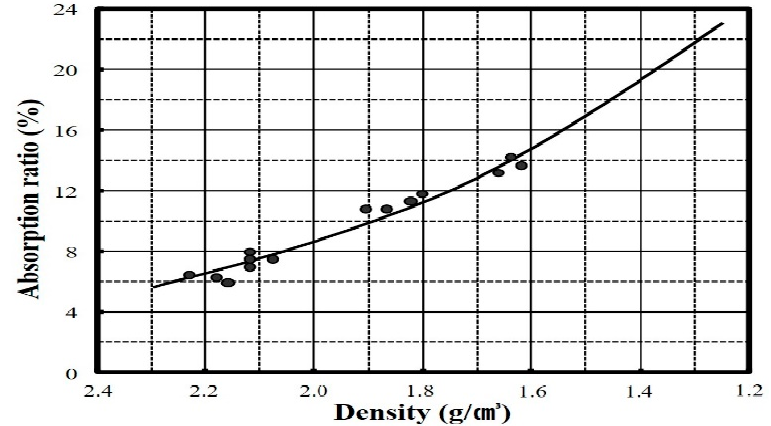
Figure 6. Relationship between the density and the absorption rate of a general aggregate (natural river aggregate or crushed aggregate). Source: Kim, H.S. A Study on the Quality Improvement of Recycled Fine Aggregate using Neutralization and Low Speed Wet Abraser. Notification on 2011-02; Kongju National University: Cheonan, South Korea, 2011.